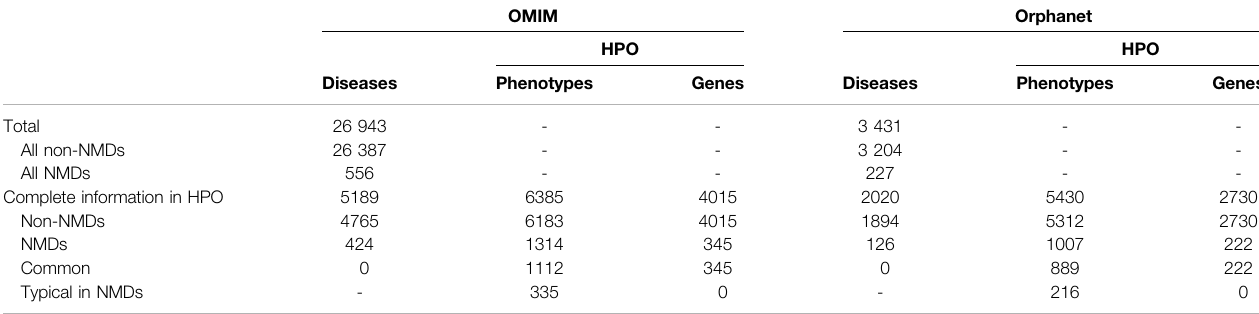
TABLE 2 | Summary of diseases found in OMIM and Orphanet databases and the retained diseases, phenotypes and genes after the HPO query.